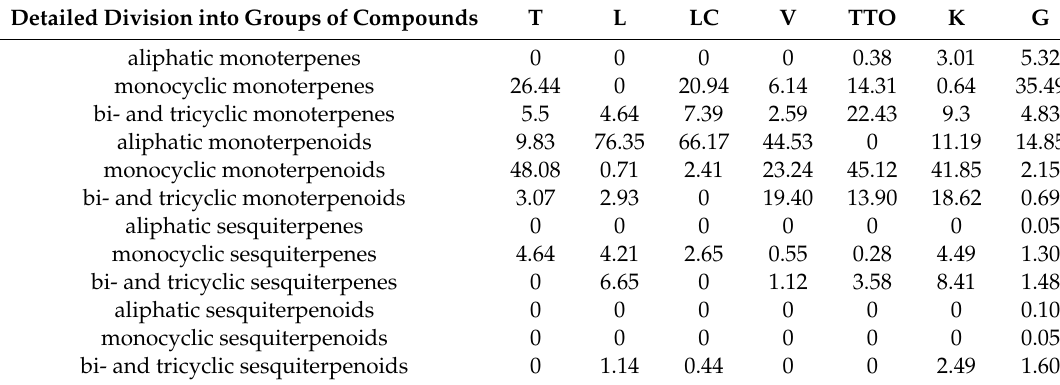
Table 4. Main groups of terpenes: thyme (T), lemongrass (L), Litsea cubeba (LC), verbena (V), tea tree (TTO), cajeput (K), and grapefruit (G) oils. Detailed Division into Groups of